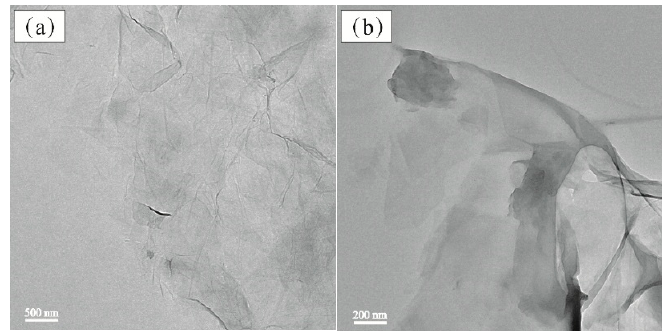
Figure 5. TEM images of GO ( a ) and GO-MD-MP ( b ).